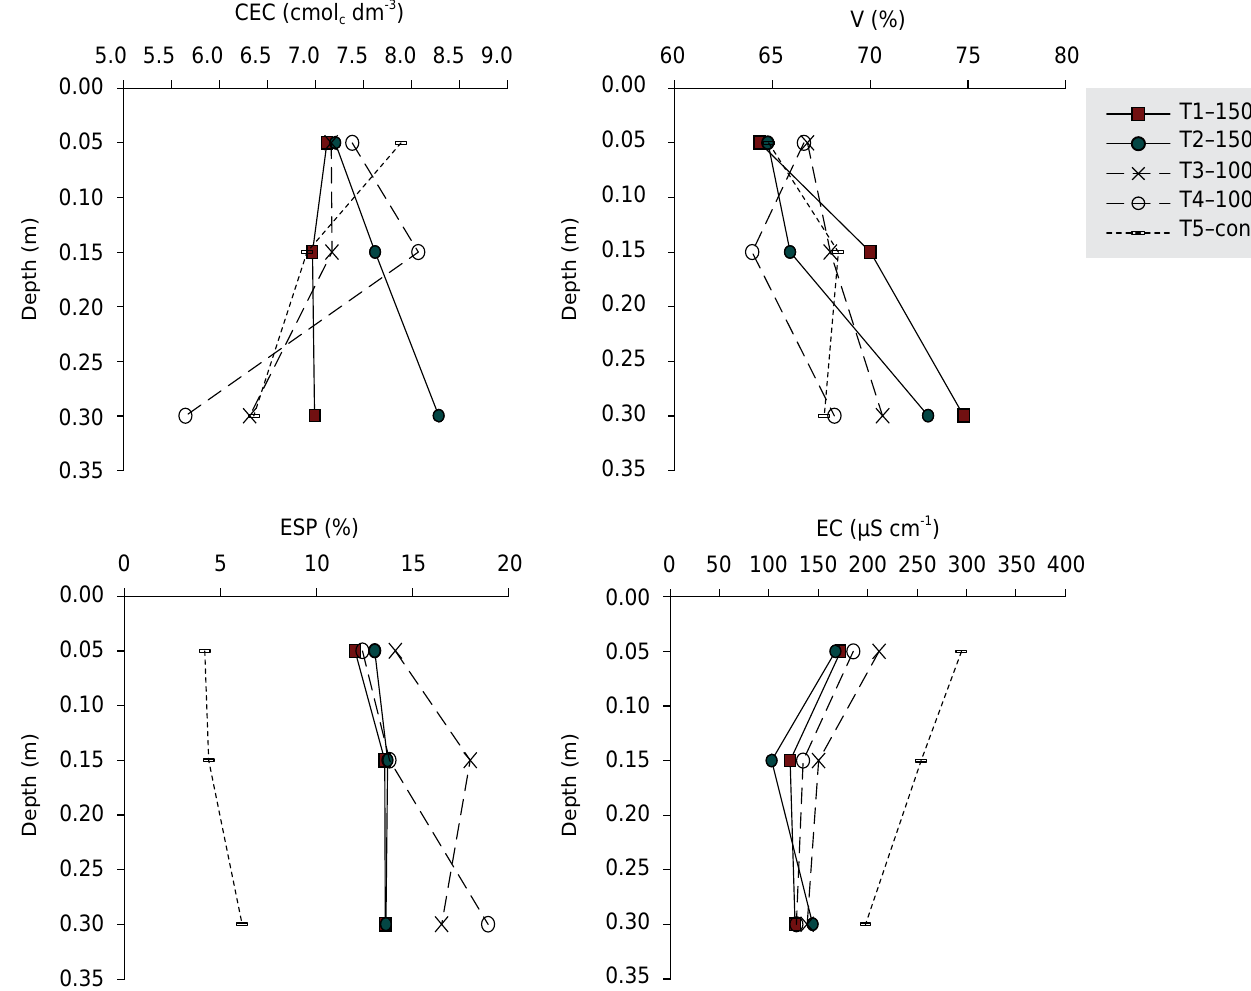
Figure 4. Average values of soil cation exchange capacity (CEC), base saturation (V), exchangeable sodium percentage (ESP), and electrical conductivity (EC) in the 0.00-0.10, 0.10-0.20, and 0.20-0.40 m layers after the